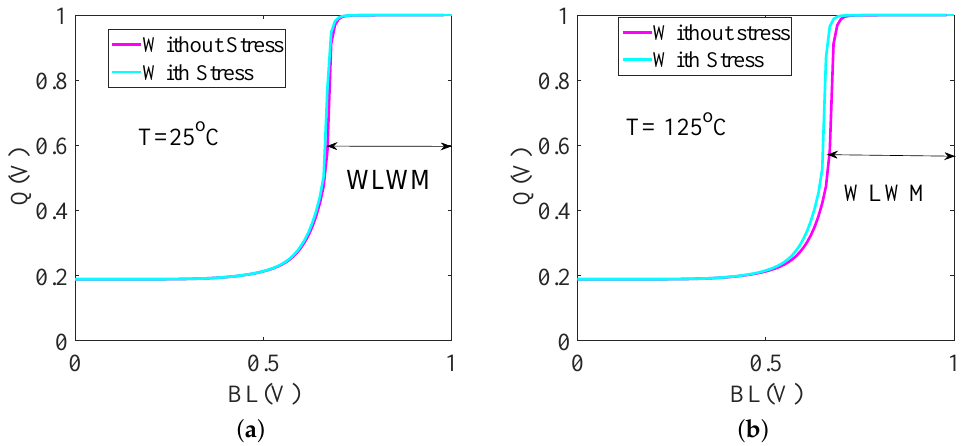
Figure 18. Degradation in WLWM under 10 year NBTI stress at ( a ) T = 25 °C. ( b ) T = 125 °C.